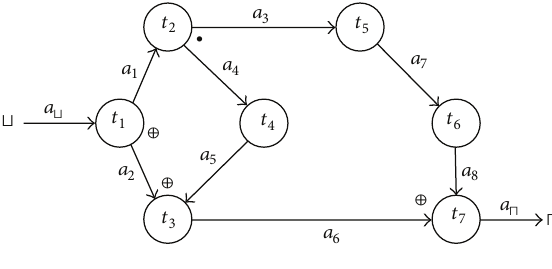
Figure 2: Example of a